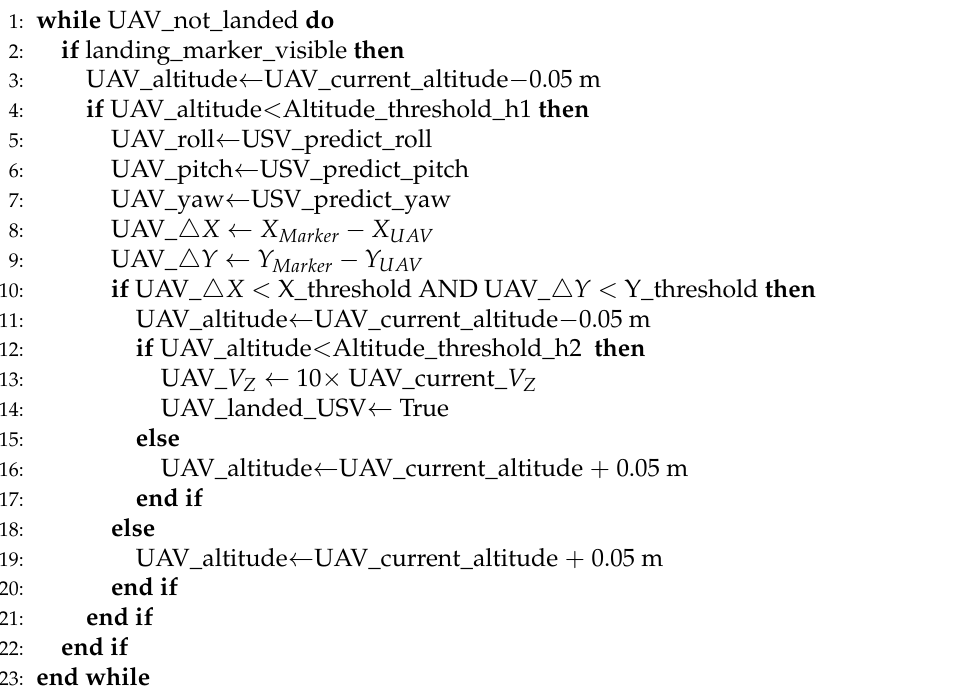
Algorithm 1 UAV–USV Synchronous Motion Landing